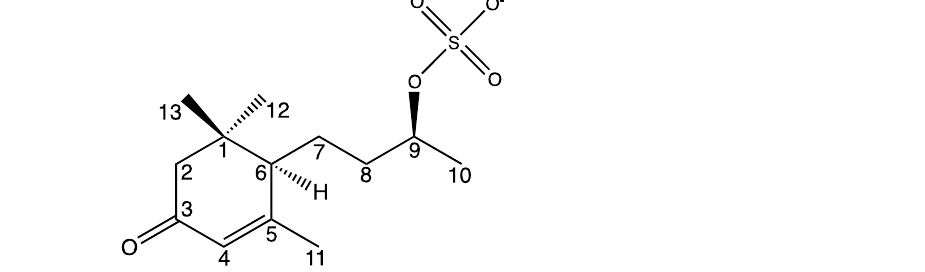
Yan et al. [30] as well to numbering in Table 1.